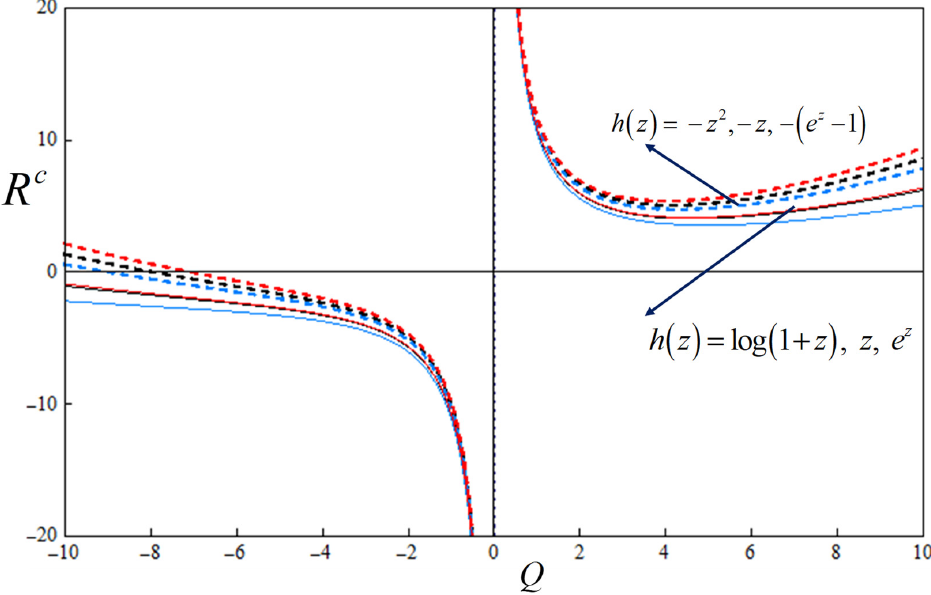
Figure 6. Plot of R c versus Q for different scenarios of gravity with Le = 0.5, Rs = 10, Da = 0, ξ = 0.5, η = 0.5 and δ =